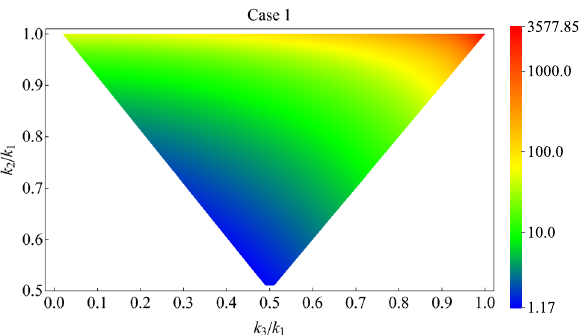
Fig. 6 The non-Gaussianity in the general form of scalene triangle configuration for Case 1